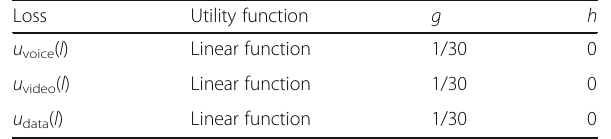
Table 3 Utility function for delay jitter and parameter settings